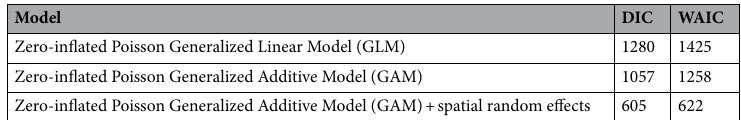
Table 2. Comparison of the three candidate models of the spatial model.